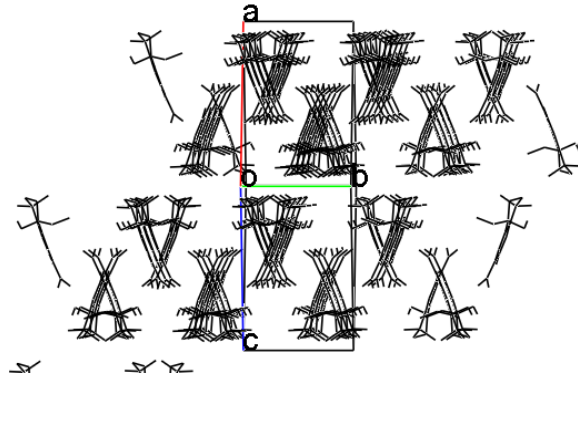
Figure 5. Layers of molecular rows aligned to the ( − 1 0 1)